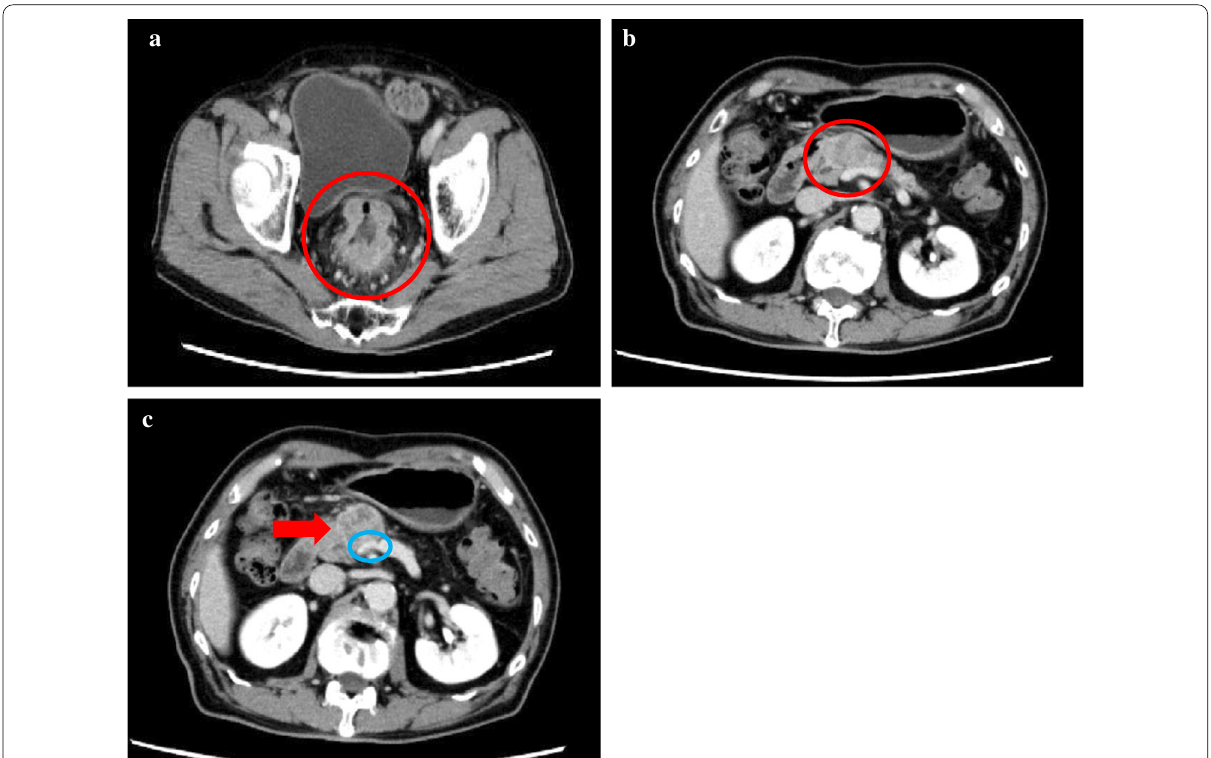
Fig. 2 Computed tomography findings at presentation. a Preoperative contrast-enhanced computed tomography showed a clearly enhanced rectal lesion in Ra (red circle) with no lymphadenopathy or distant metastasis. b Contrast-enhanced computed tomography also revealed a poorly enhanced tumor 3 cm in size in the pancreatic head (red circle). c The pancreatic tumor (red arrow) widely abutted the superior mesenteric vein (blue circle)